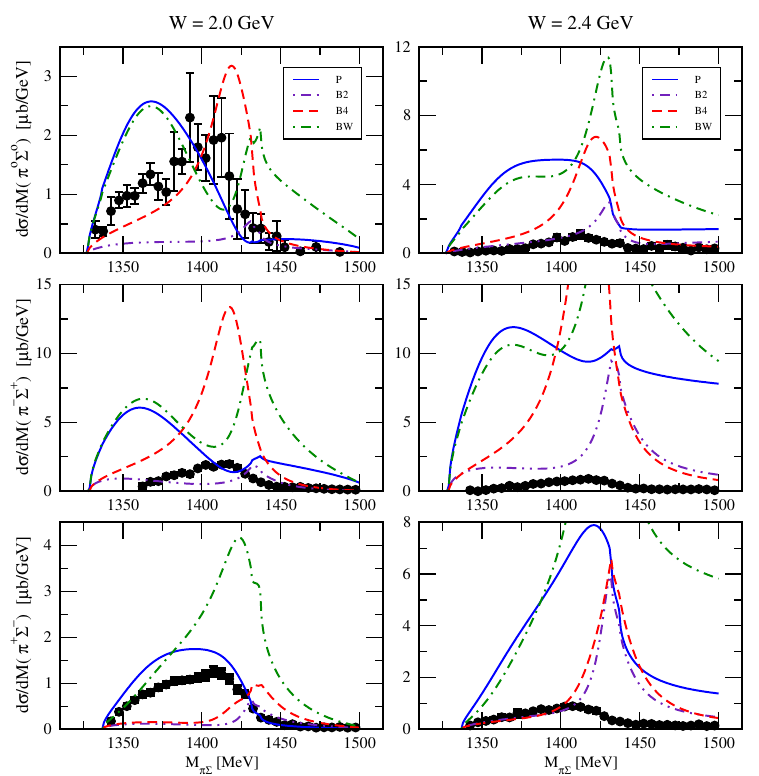
Figure 2. Comparison of π Σ mass distributions calculated at two c.m. energies, W = 2 . 0 and 2 . 4 GeV, while employing MB amplitudes generated by four di ff erent coupled-channel models. The experimental data are taken from